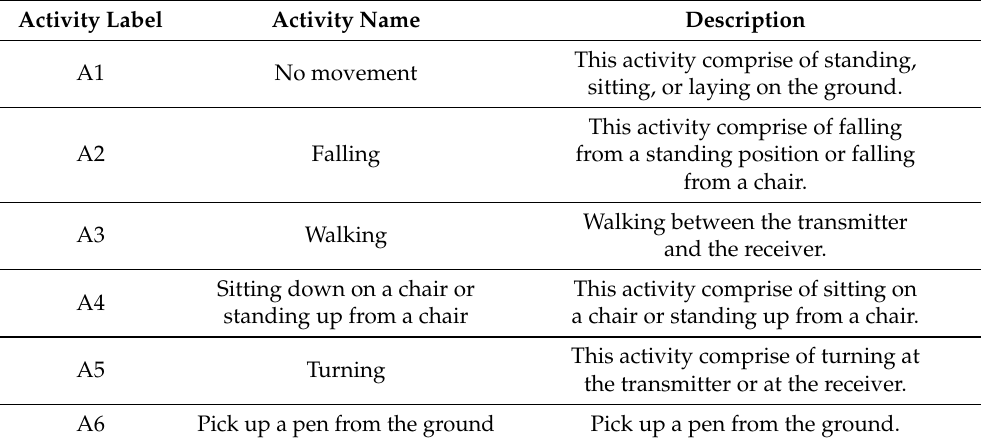
Table 2. Summary of the identified activities within the performed experiments.